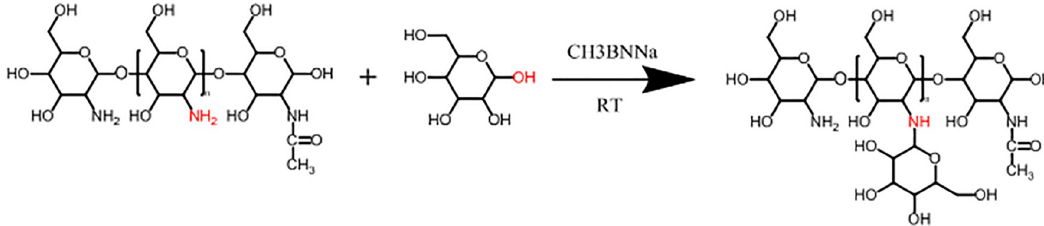
Fig 1. Synthetic route of mannose-modified chitosan